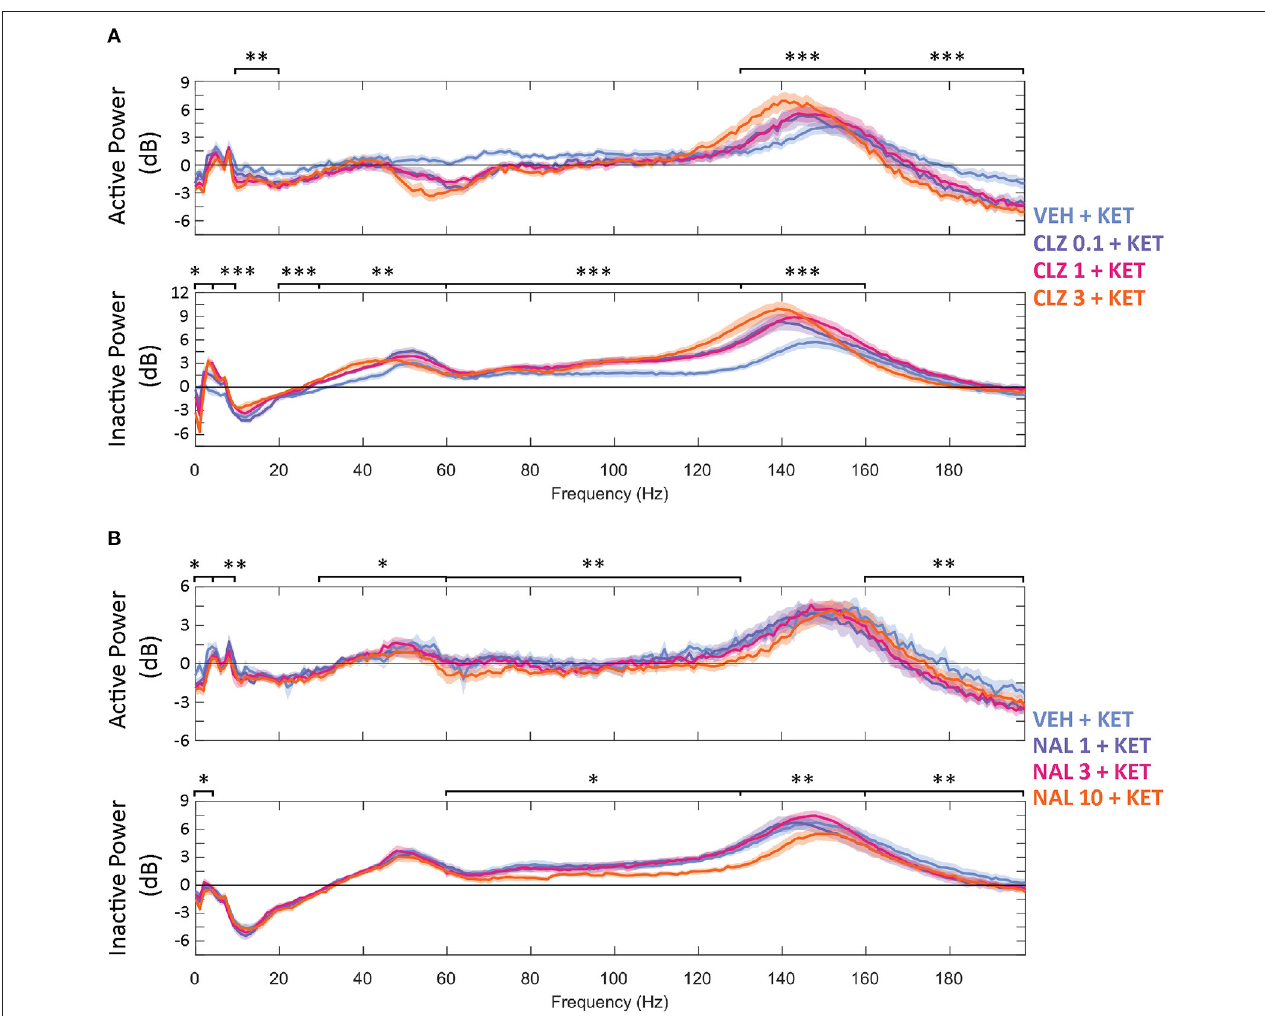
FIGURE 2 | Baseline-normalised, averaged spectra recorded at the NAc of CLZ (A) and NAL (B) groups between 40 and 70min (10min after KET and 40min after pre-treatment). Displayed in dB change from baseline. Legends give pre-treatment doses in mg/kg. Significant differences of pre-treatment + KET spectra vs. VEH = KET are indicated by * p < 0.05/** p < 0.01/*** p < 0.001. VEH, saline; KET, ketamine 10 mg/kg; CLZ, clozapine; NAL, naltrexone.